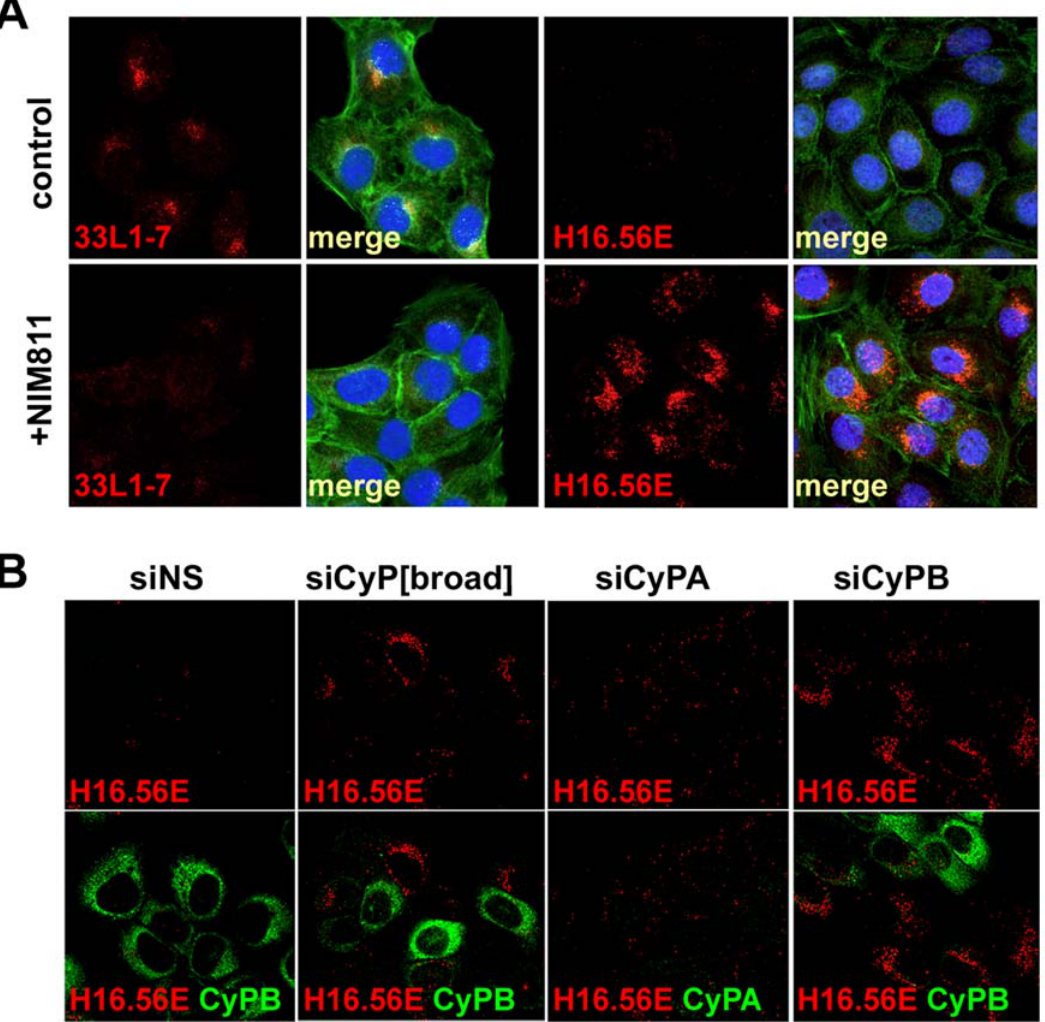
Figure 3. Inhibition of CyP leads to noninfectious HPV16 internalization. (A) HaCaT cells were infected with HPV16 pseudovirus in the absence or presence of NIM811. At 18 hpi cells were fixed and stained using conformation-dependent NmAb H16.56E or linear epitope-specific nonneutralizing 33L1-7. Cells were also stained for actin and DNA using AF 488 –labeled phalloidin (green) and Dapi (blue), respectively. Images were taken with a Leica DBMI6000 at 40 6 magnification. (B) HaCaT cells were transfected with indicated siRNA. At 48 hpTx, cells were harvested and reseeded for infection with HPV16 pseudovirions. At 18 hpi cells were fixed and stained using H16.56E (red) and CyPA or CyPB (green). Images were taken with a confocal Zeiss LSM 510 microscope at 63 6